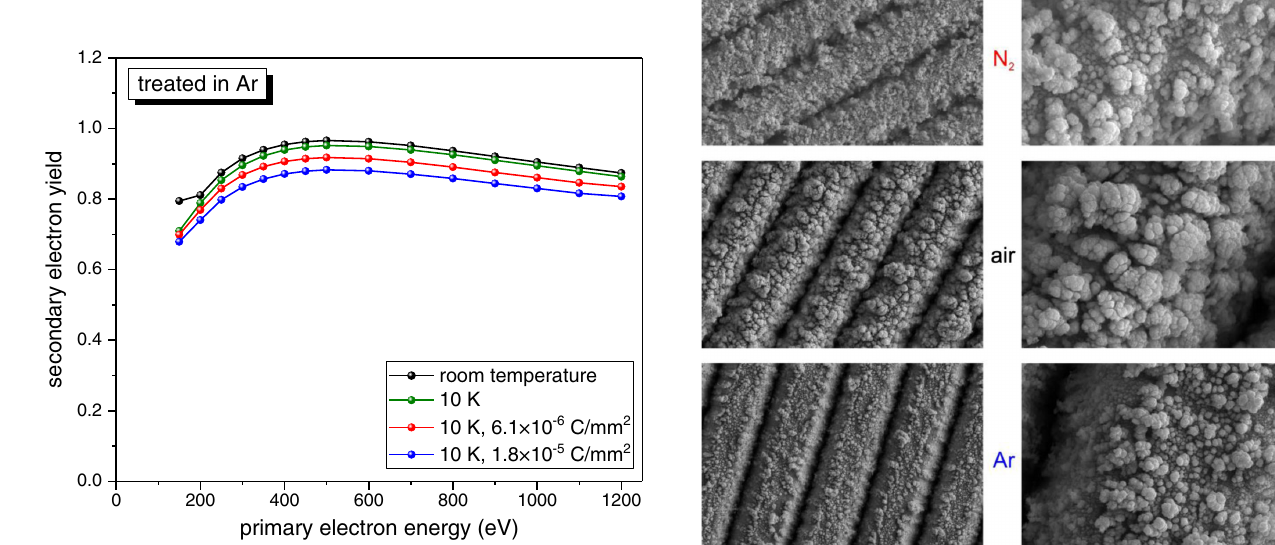
FIG. 11. Scanning electron micrographs of LH-patterned sur- faces treated in nitrogen (top), air (middle), and argon (bottom) at two different